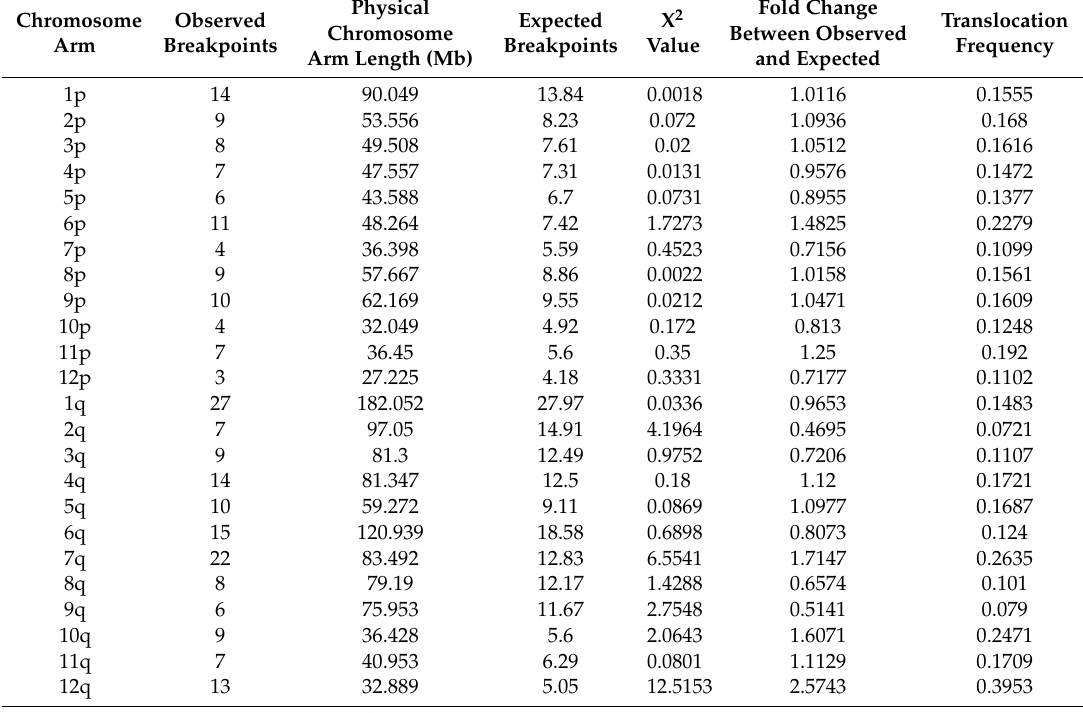
Table 2. The distribution of translocation breakpoints across chromosome